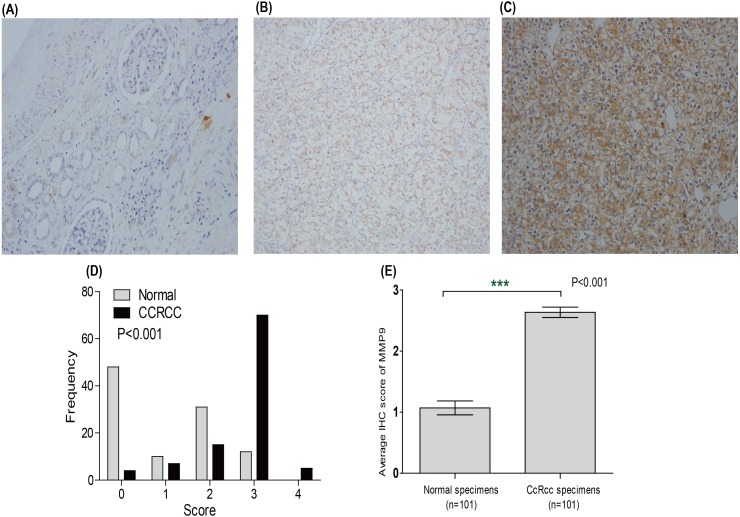
The protein level of MMP9 in ccRCC.The protein expression of MMP9 in ccRCC tissues and their adjacent normal renal tissues were compared using immunohistochemical staining. Representative adjacent normal renal tissues staining (A), ccRCC tissues staining (B), frequency distributions of proteins expression across the cohort (C), and the average score of immunohistochemical staining (D) were shown.